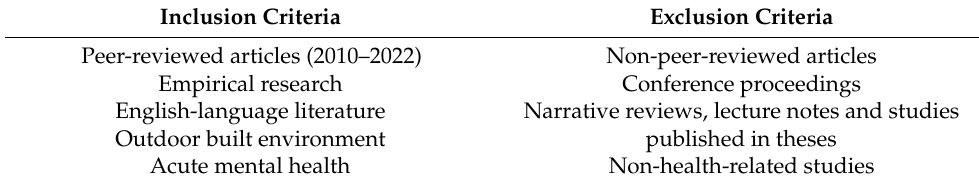
Table 2. Inclusion and exclusion